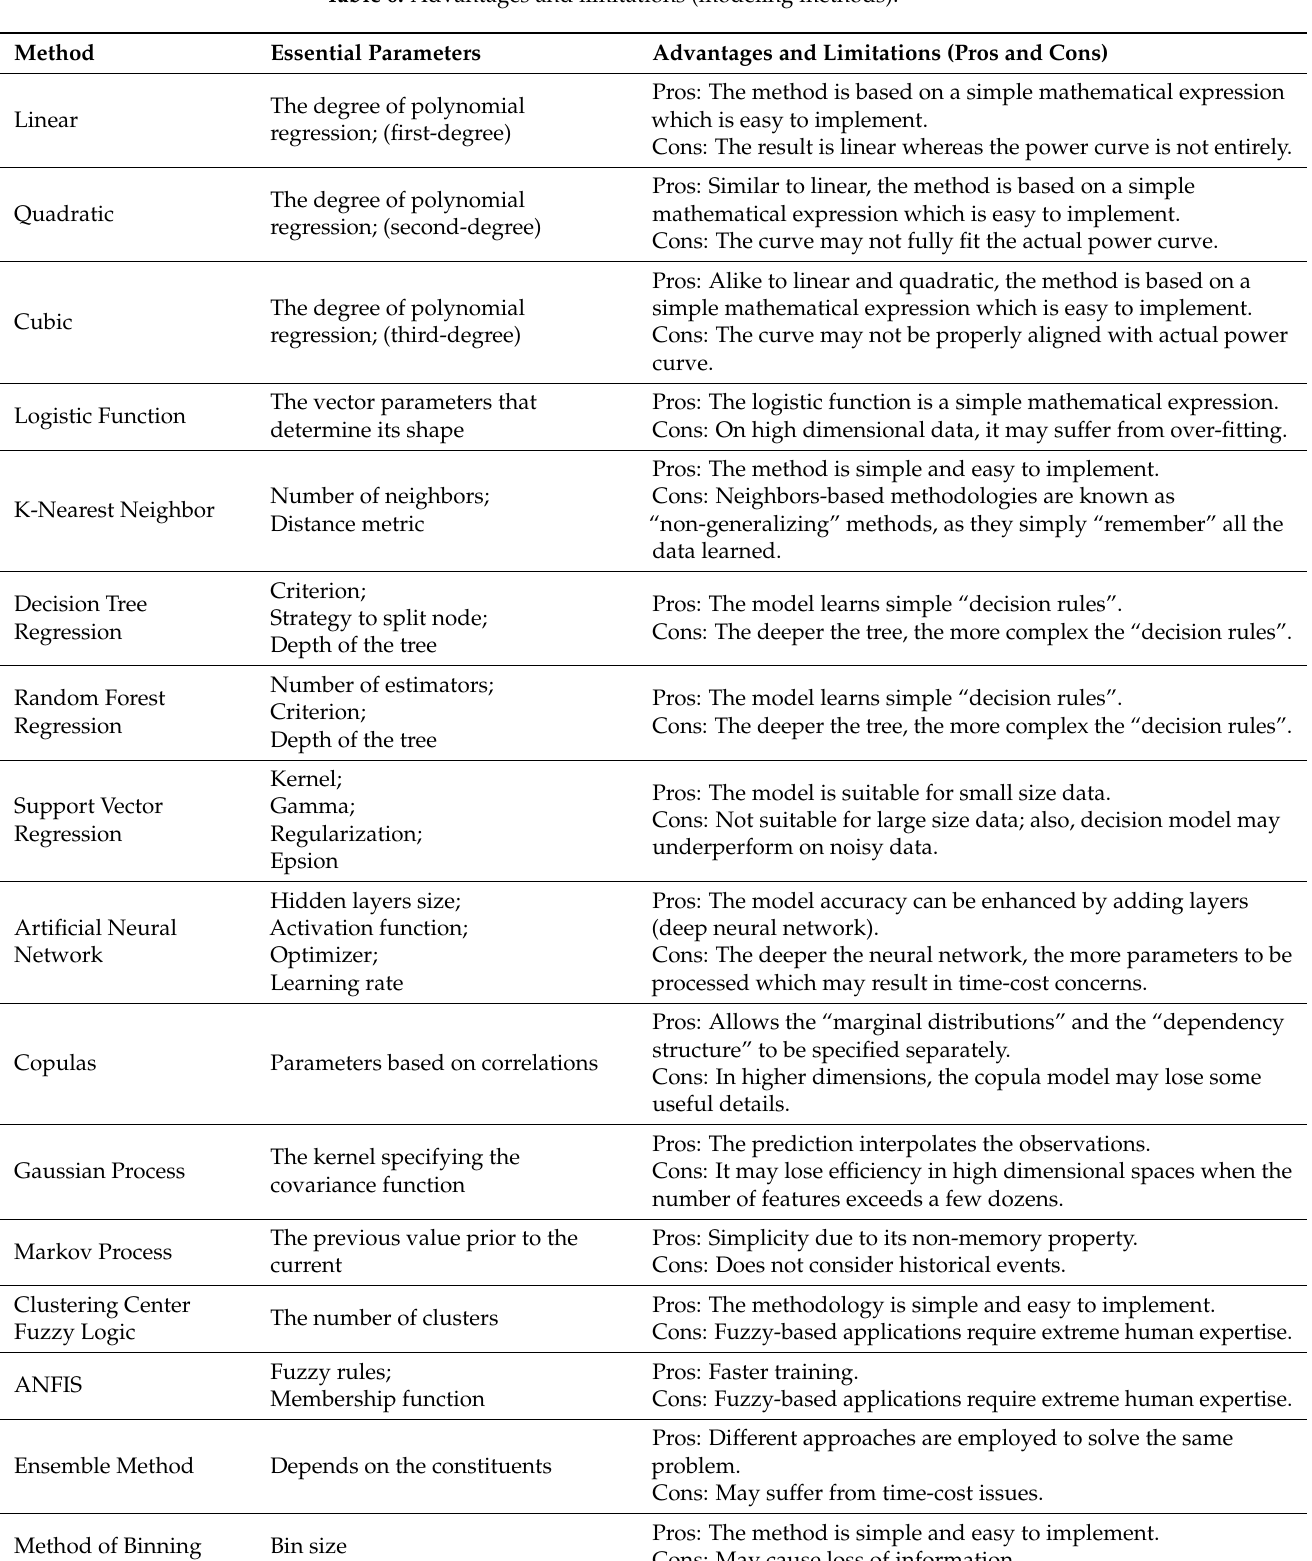
Table 6. Advantages and limitations (modeling